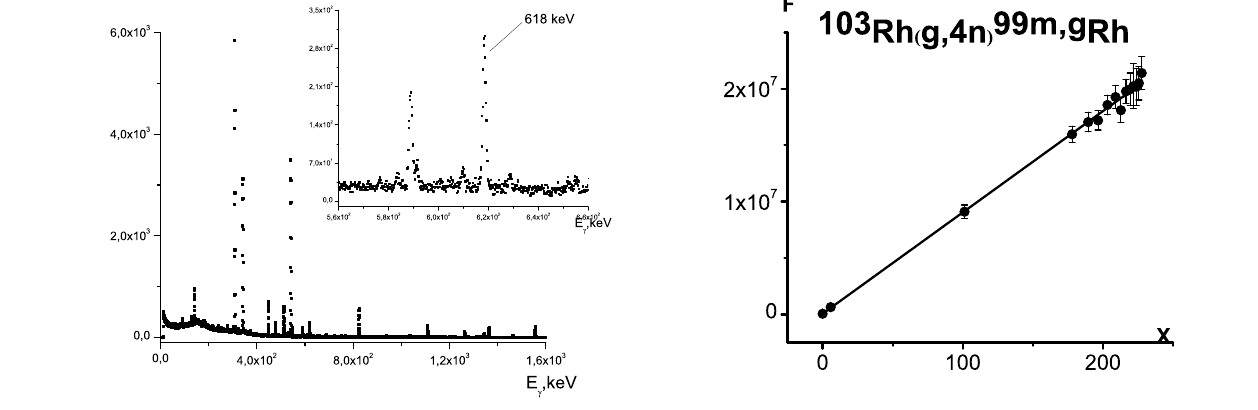
Figure 1. Gamma-ray spectra from the rhodium activities. The analytical gamma lines used for determination of the isomer ra- tios are indicated separately